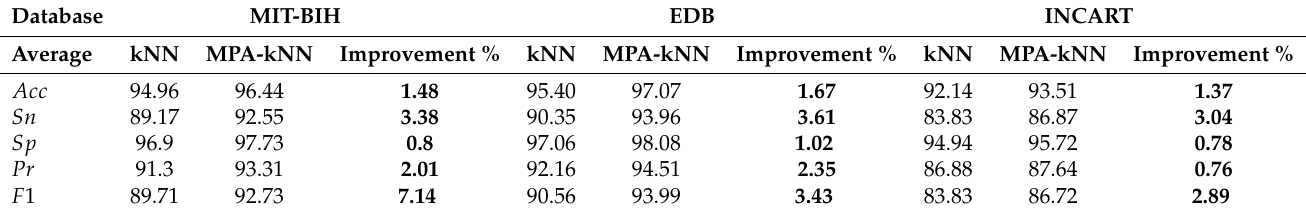
Table 11. The performance comparison of the kNN and its optimized version, the